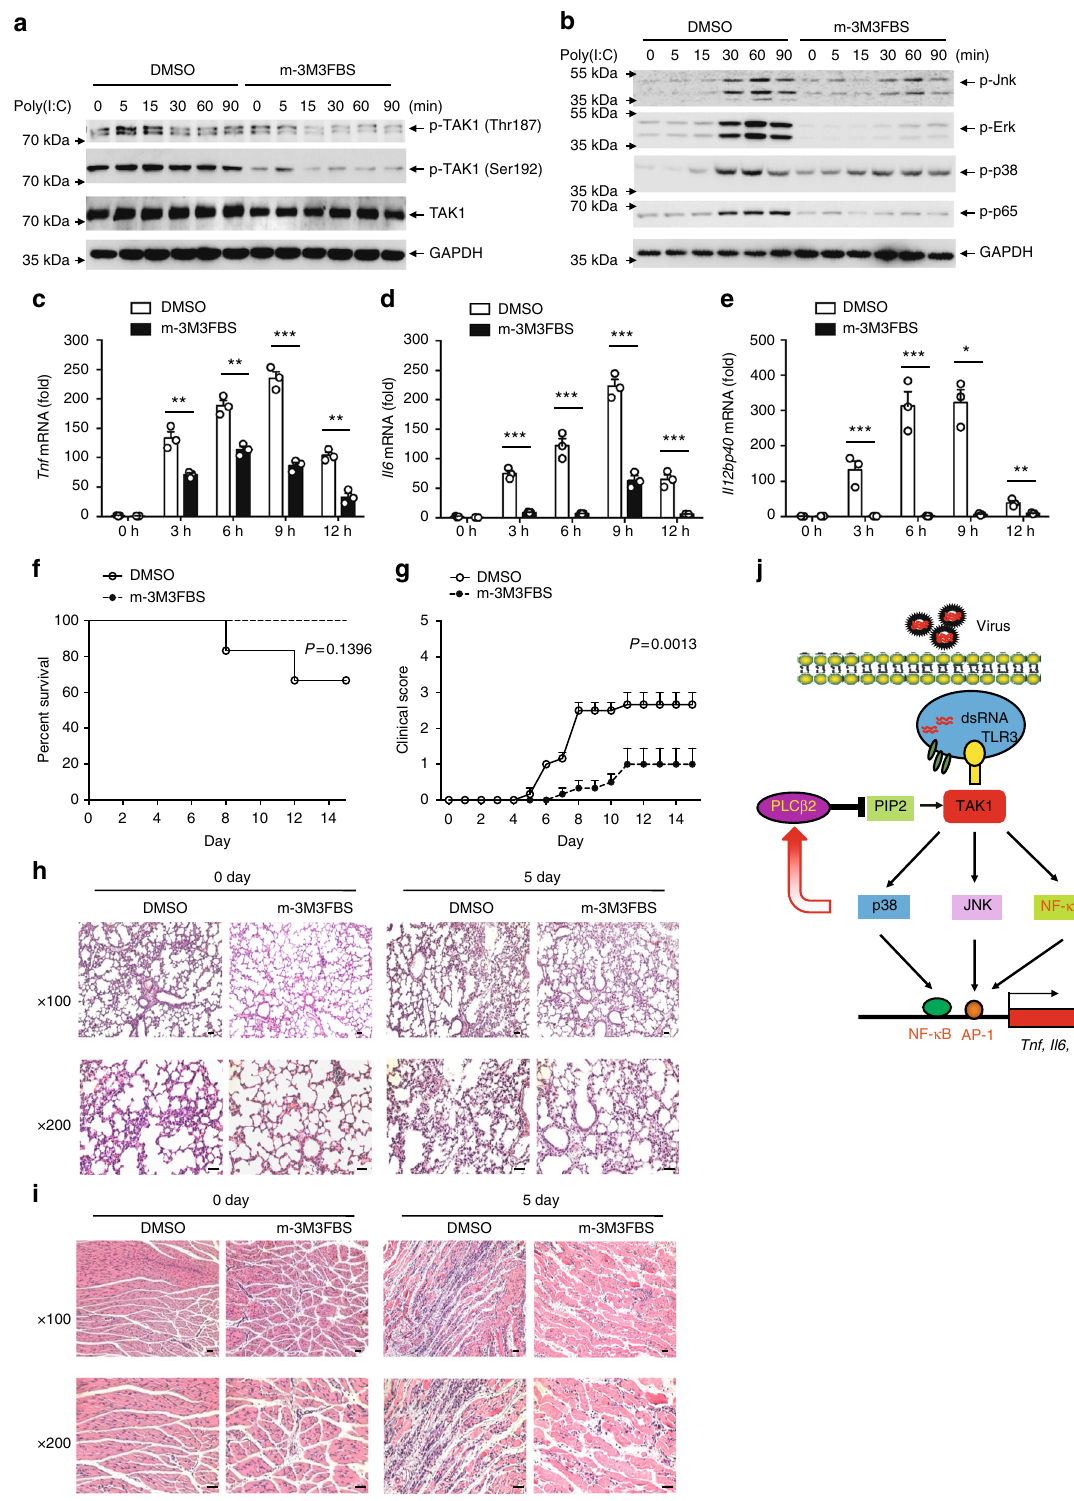
Fig. 7 PLC β 2 activator alleviates the pathogenesis of CVA16 infection. a , b Immunoblot analysis of lysates from macrophages pretreated with DMSO or m-3M3FBS, and then stimulated with poly(I:C) for the indicated times using different phospho-antibody. c – e Q-PCR analysis of relative Tnf ( c ), Il6 ( d ) and Il12p40 ( e ) mRNA in macrophages pretreated with DMSO or m-3M3FBS, then stimulated with poly(I:C) for the indicated times. Fourteen-day-old wild-type mice were pretreated with DMSO or m-3M3FBS and subsequently infected with CVA16 for 0 or 5 days. f – i Survival rate ( f ), clinical score ( g ) and histopathology in lung ( h ) or skeletal muscle ( i ) tissue of mice treated as above at either day 0 (not infected) or day 5. Scale bar, 50 μ m. j Diagram. * p < 0.05; ** p < 0.01 and *** p < 0.001 by unpaired t -test ( c – e ). Gehan – Breslow – Wilcoxon test ( f ) and two-way analysis of variance plus Bonferroni ’ s posttest ( g ) were used to calculate p value. Data are representative of three experiments with at least three independent biological replicates (mean and s.e.m. of n